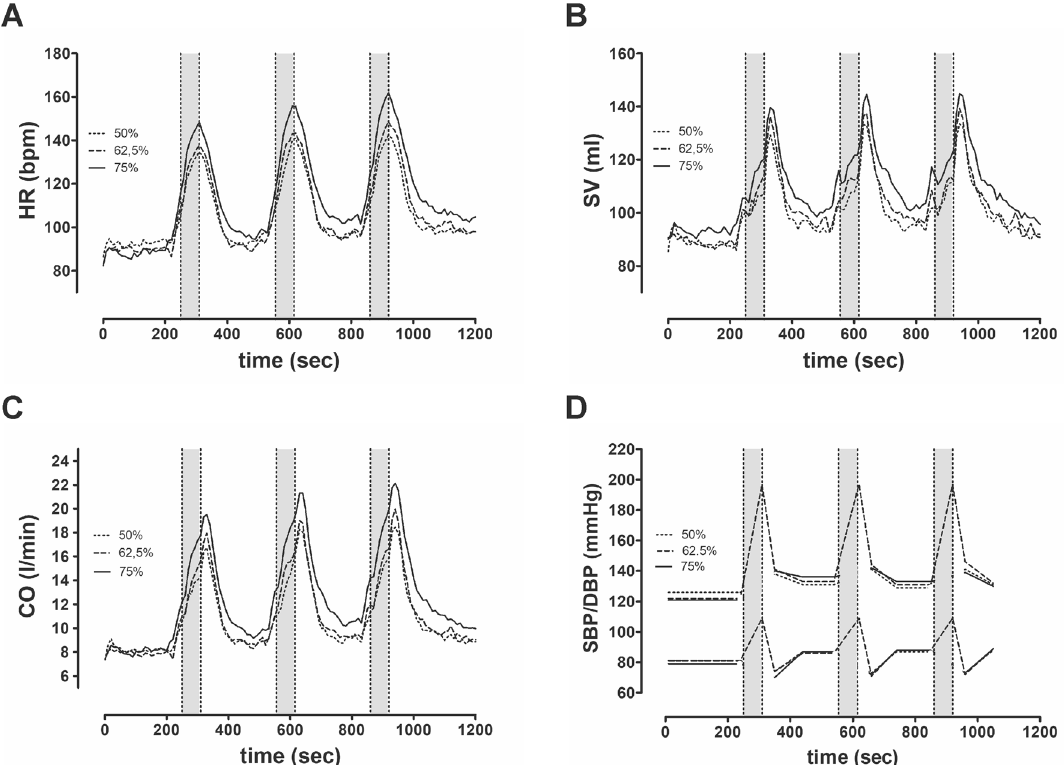
Figure 2. Graphs show the mean cardiac response (n = 14) during strength training sessions with ( A ) heart rate; ( B ) stroke volume, ( C ) cardiac output and ( D ) systolic—and diastolic blood pressure; Exercise blood pressure is only illustrated during 62.5%